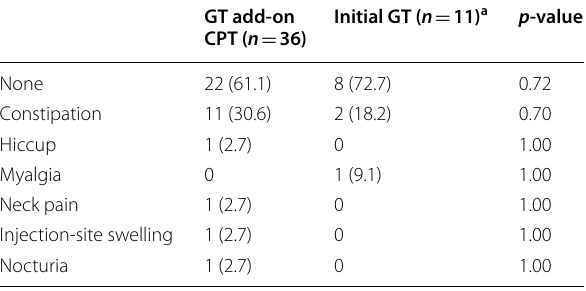
GT galcanezumab therapy, CPT conventional preventive therapy a Five patients added other conventional preventive therapies after the start of